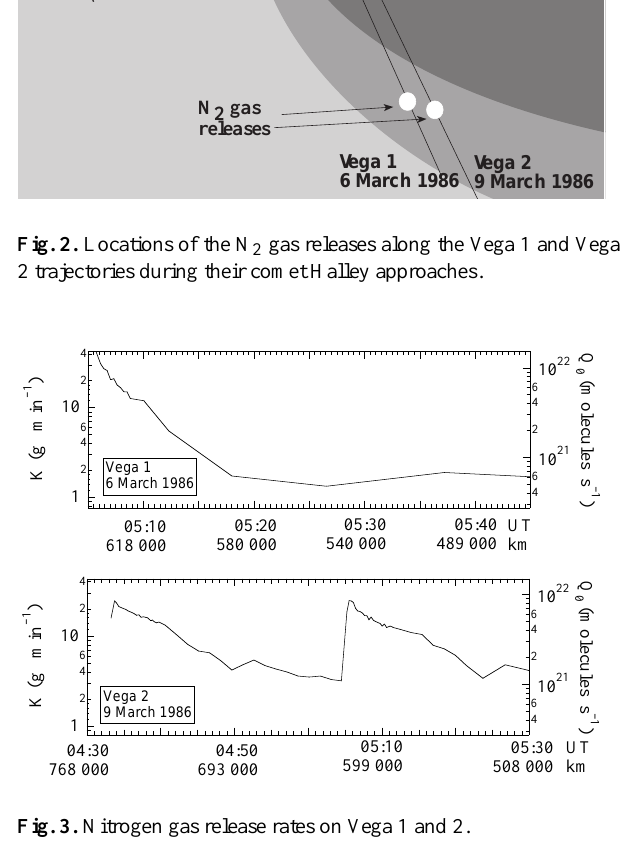
is given along the left-hand axis and Q 0 (molecules s − 1 ) is given along the right-hand axis. The two numbers are